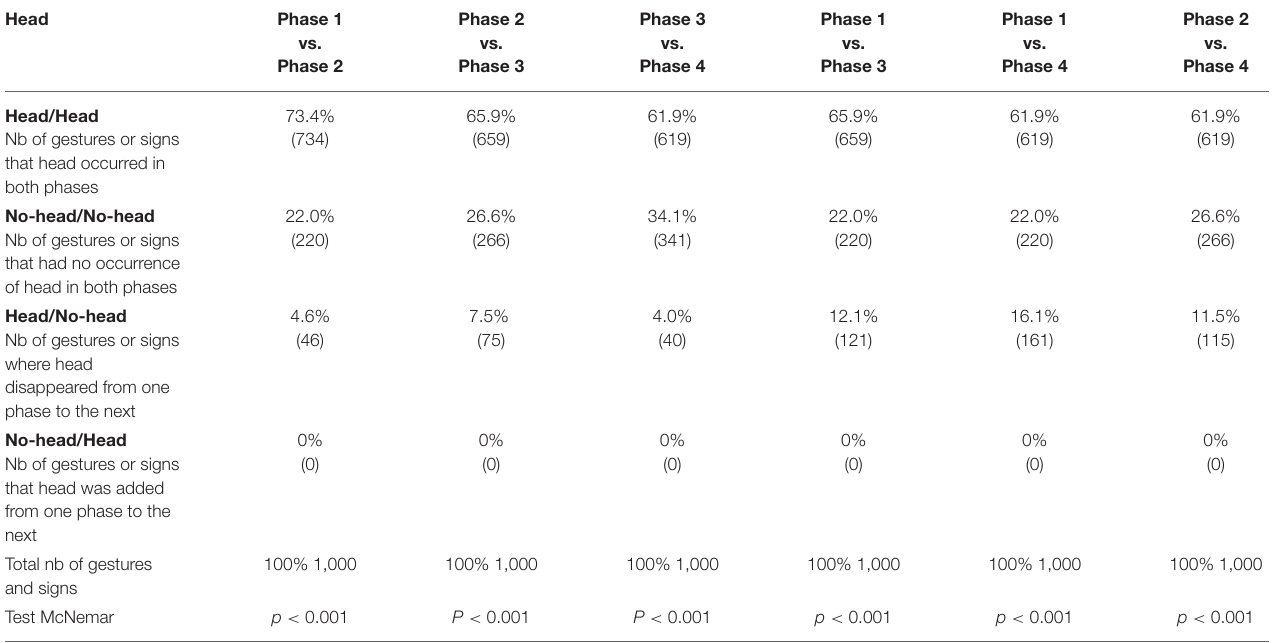
TABLE 3 | McNemar Test: Comparison of pair of phases based on the number of gestures or signs in which head occurred and not occurred considering the analyzed 1,000 gestures and signs. Head Phase 1